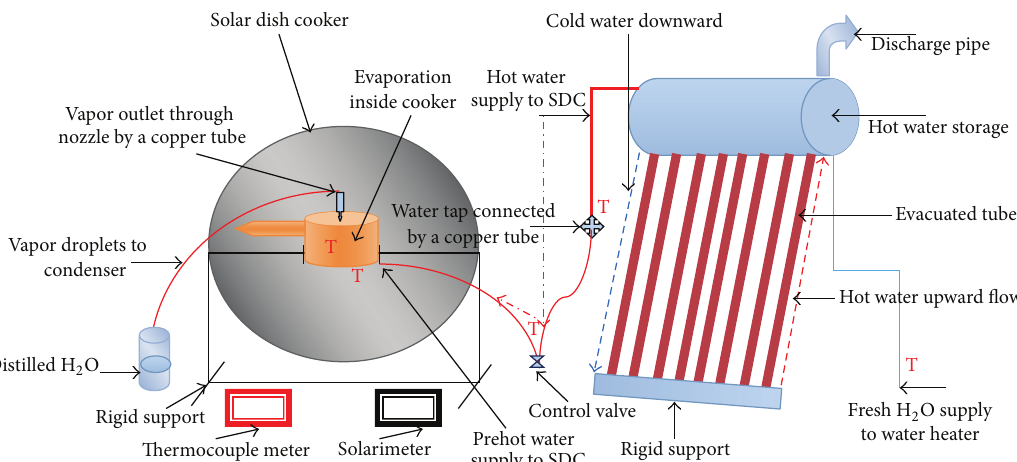
Figure 3: Schematic diagram of a high rated solar distilling unit; “T” is denoting the locations of thermocouple sensors, which were placed to measure the temperature variations at different positions.